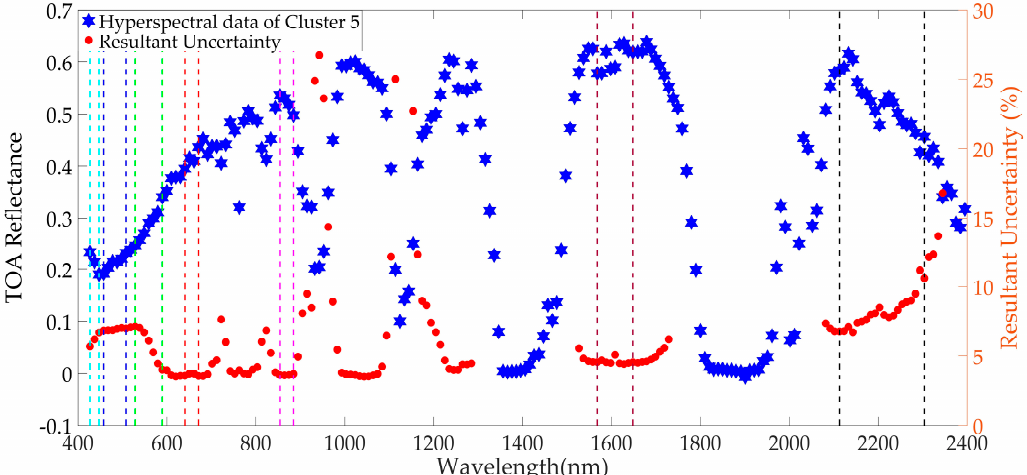
Figure A3. Estimated representative hyperspectral profile of Cluster 5 and its resultant uncertainty.